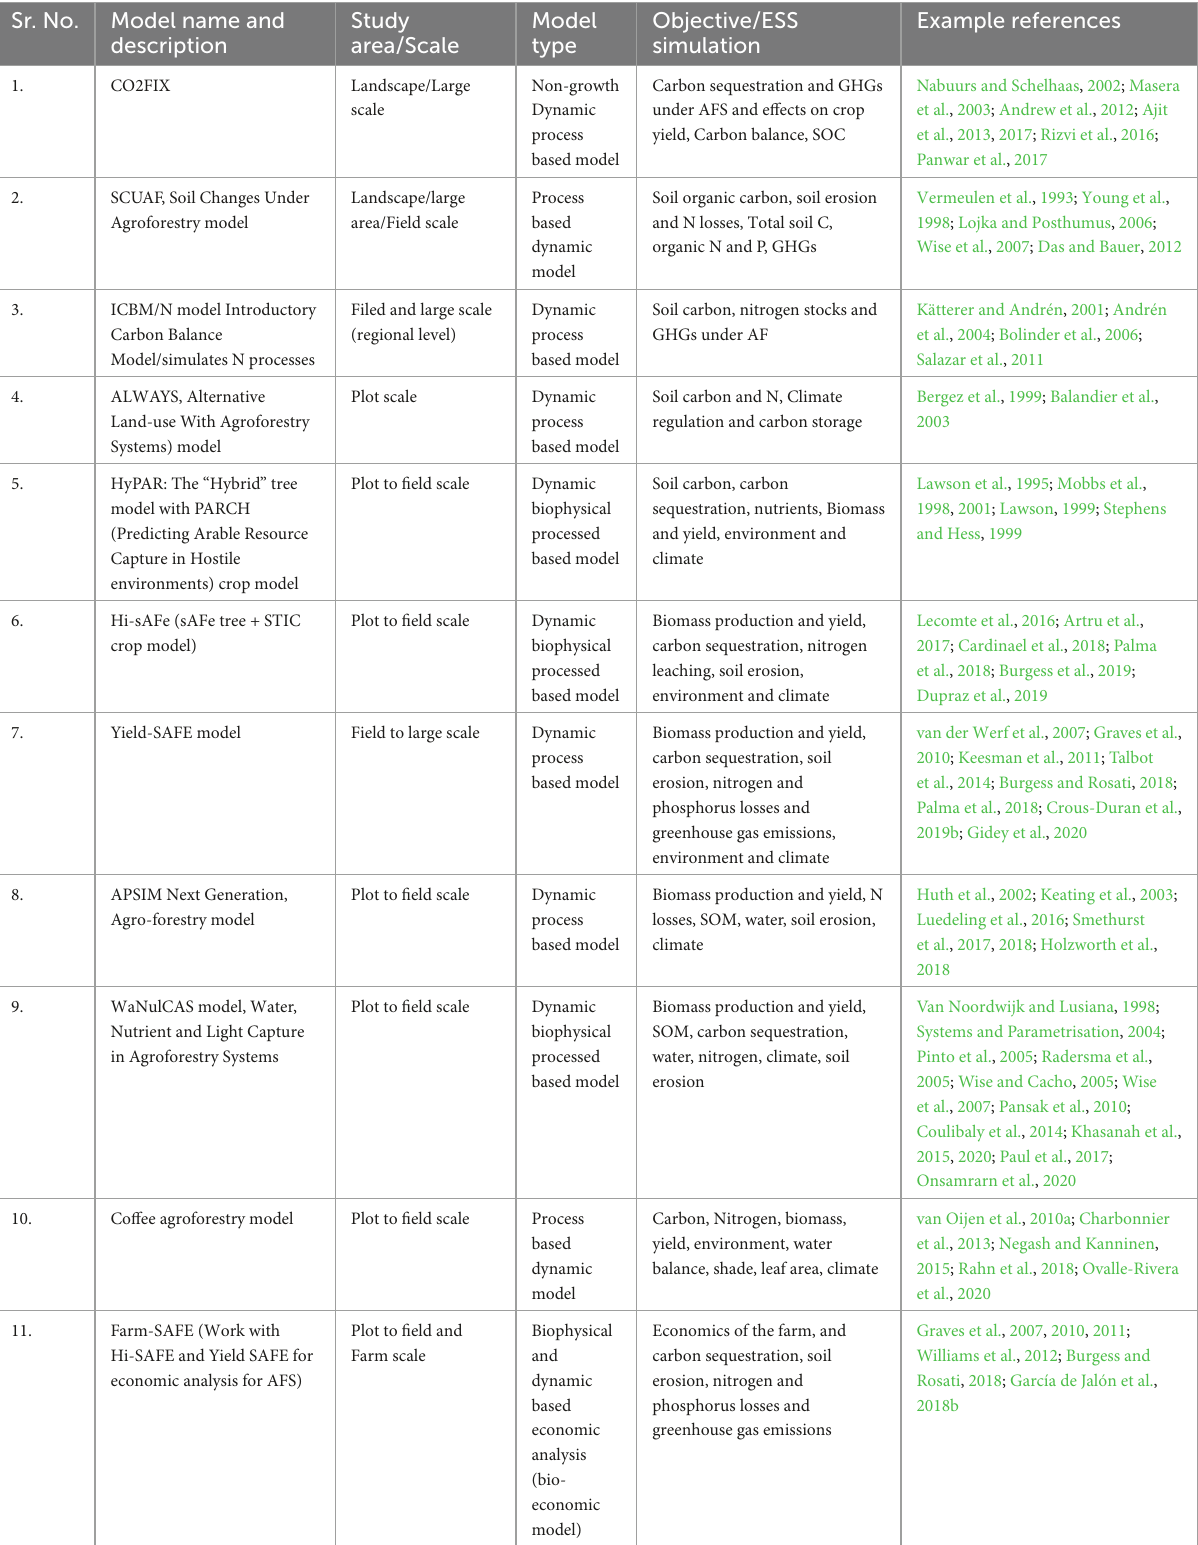
TABLE 2 Ecosystem services (ESS) simulations using available modeling approaches for agroforestry systems (AFSs). Sr.